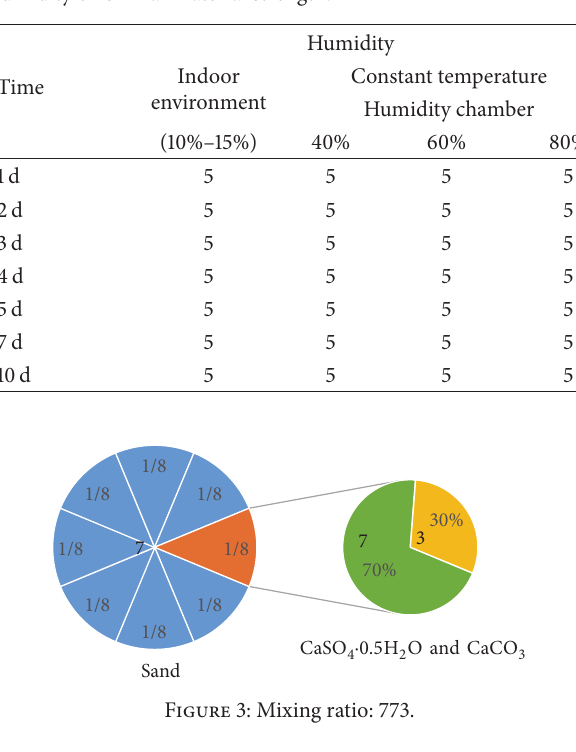
Table 2: Experiment scheme for analyzing the influence of curing humidity on similar material strength.